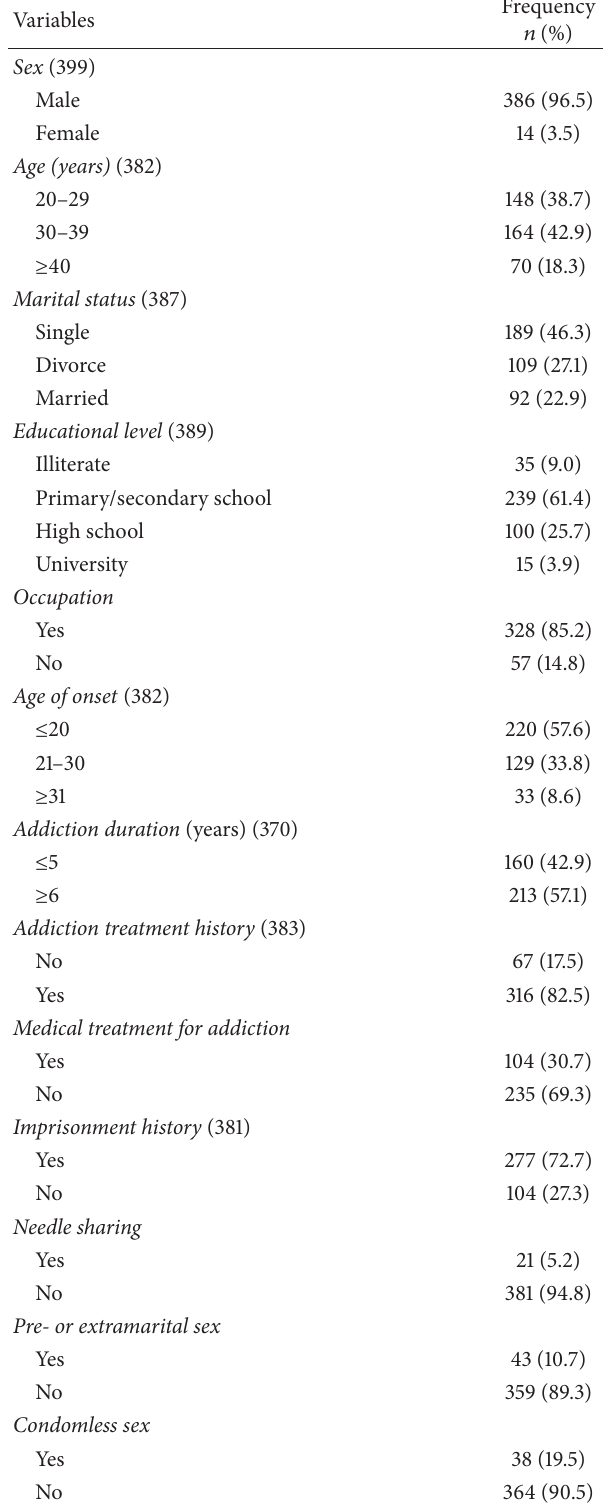
Table 1: Baseline characteristic of